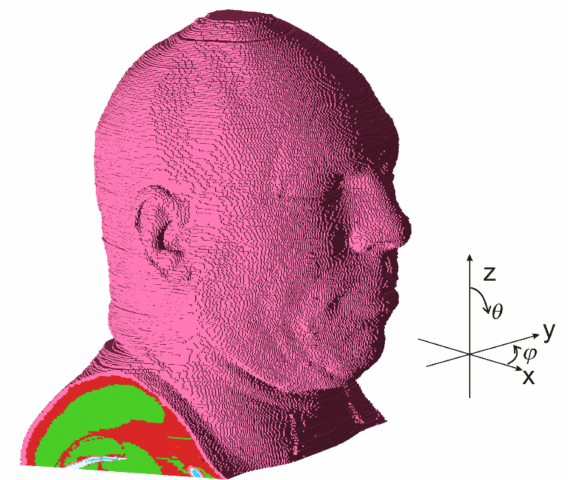
Figure 1. Numerical model of the human head used for simulations.